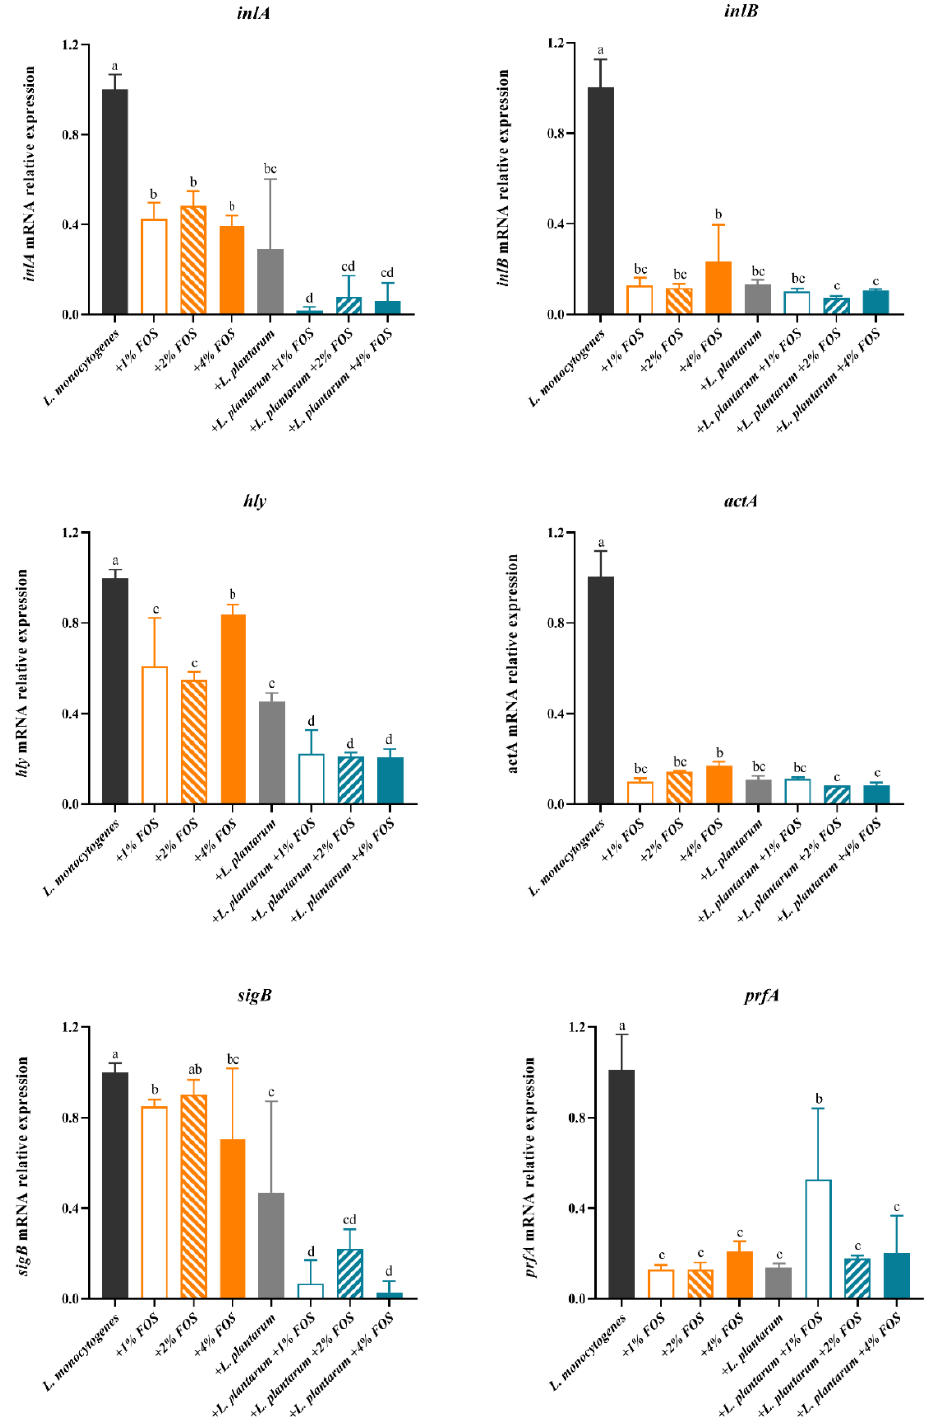
Figure 5. Relative expression levels of virulence genes of L. monocytogenes in BHI at 10 °C for 12 days in different treatment groups: (1) the untreated group (black bar), (2) 1% ( w / v ) FOS (orange hollow bars), (3) 2% ( w / v ) FOS (slash orange bars), (4) 4% ( w / v ) FOS (orange bars), (5) L. plantarum supplementation group (dark gray bars), (6) L. plantarum + 1% ( w / v ) FOS (blue hollow bars), (7) L. plantarum + 2% ( w / v ) FOS (slash blue bars), (8) L. plantarum + 4% ( w / v ) FOS (blue bars). Values are mean ± SD ( n = 6). At each temperature, different lowercase letters (a, b, c, and d) indicate significant differences ( p < 0.05) among